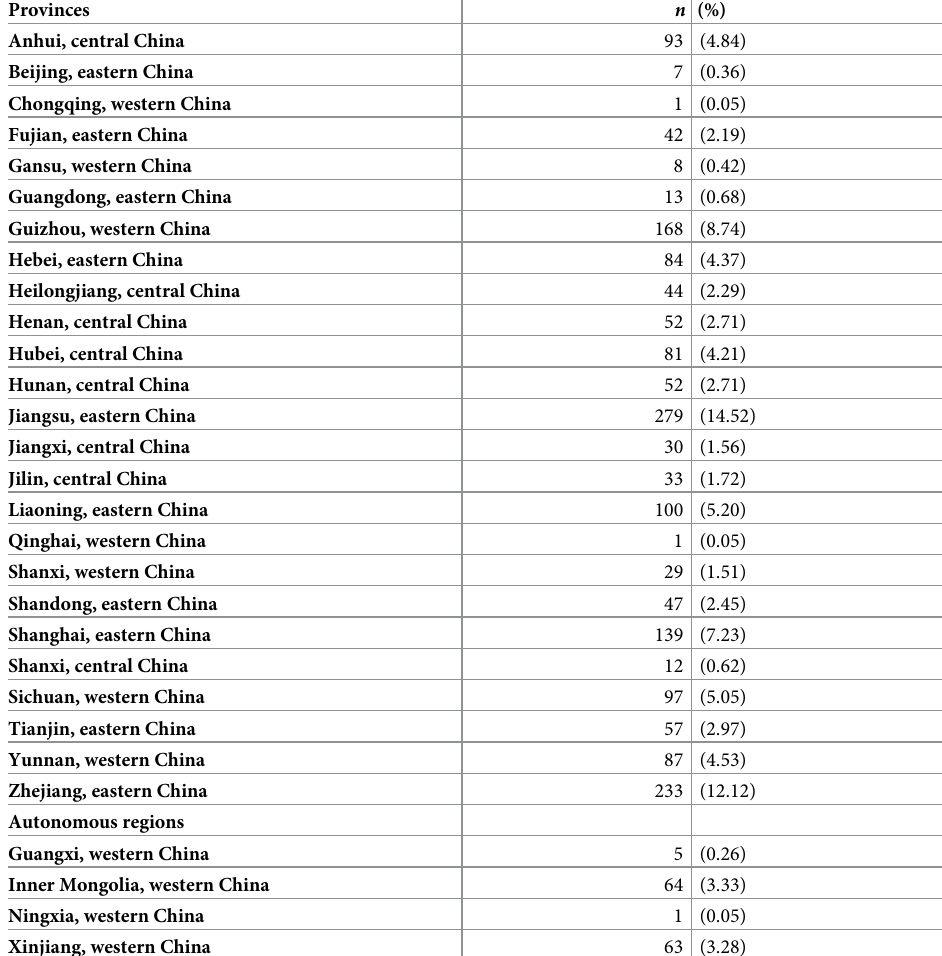
Table 2. Provinces of orthopedic medical malpractice in China between 2016 and 2017.